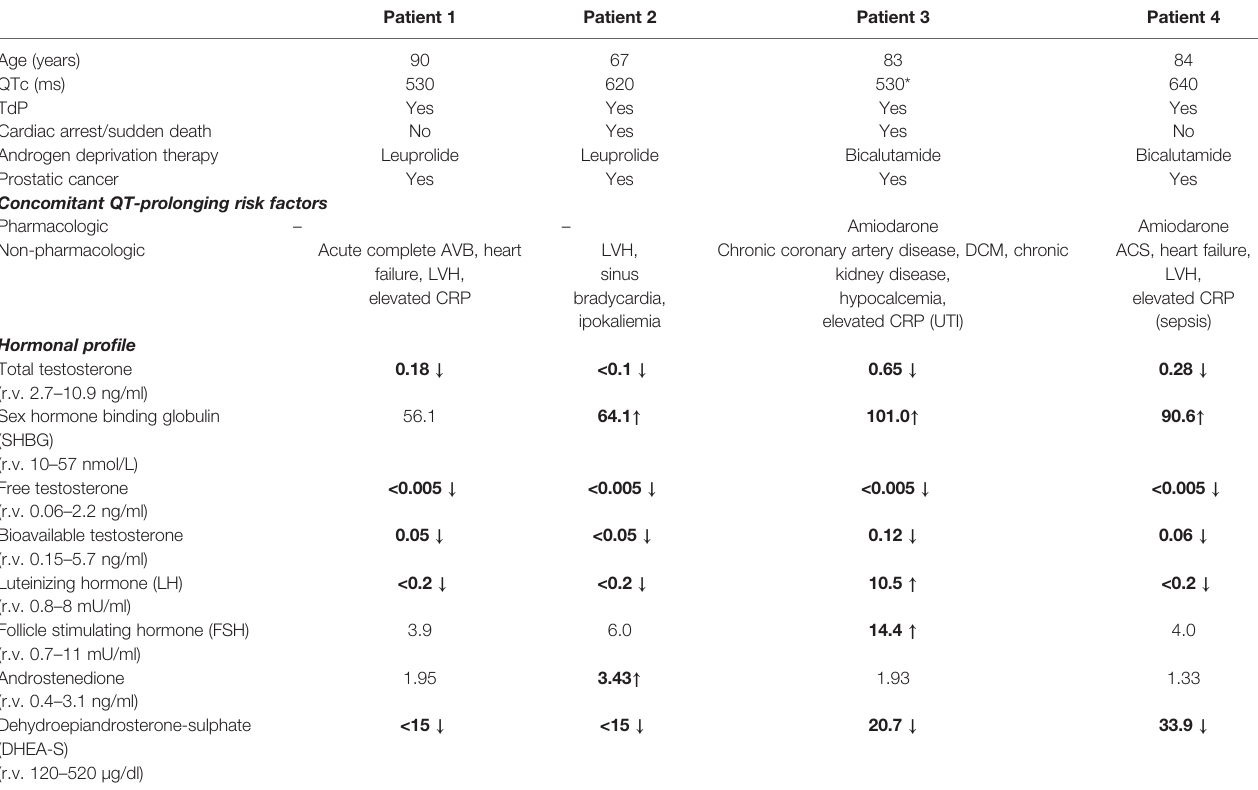
TABLE 3 | Demographic, clinical, and laboratory characteristics of patients by